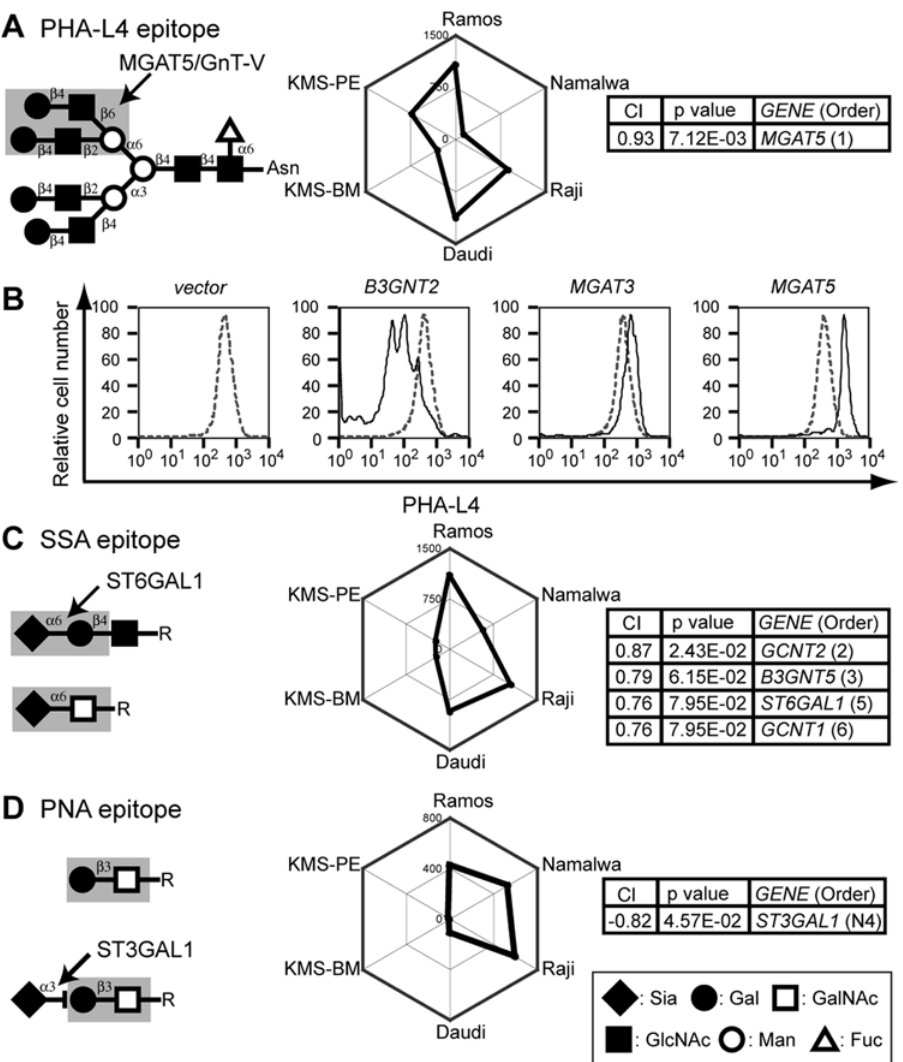
Figure 2. CIRES analyses of staining profiles obtained using lectins with known epitope expression-regulating enzymes. (A, C, D) Expected glycan structures for lectin recognition (left), web graphs of the lectin staining profiles (depicted as polygons) obtained using a set of six B-cell lines (middle), and the correlation indexes (CI, Pearson’s correlation coefficient for profile matching) of the relevant genes that correlated with the plant lectin staining profiles and the P values of the correlations (right). The correlation orders of the glycan-related genes selected from the complete list of correlated genes (Table S2) are indicated as numbers in parentheses in the box for each gene, with a smaller number indicating a stronger correlation between gene expression and glycan expression profiles. Genes with a negative correlation are indicated by an N before the order number. The lectins used were (A) PHA-L4, (C) SSA, and (D) PNA. Lectin epitopes shown in the figures are taken from the literature unless otherwise specified [17,51]. (B) Namalwa cells were infected with MSCV harboring MGAT5-IRES-EGFP . Control cells were infected with empty vector ( IRES-EGFP ) or the same vector encoding B3GNT2 or MGAT3 . Flow cytometry results for PHA-L4 staining were compared between EGFP-positive cells (solid line) and EGFP-negative cells (dashed